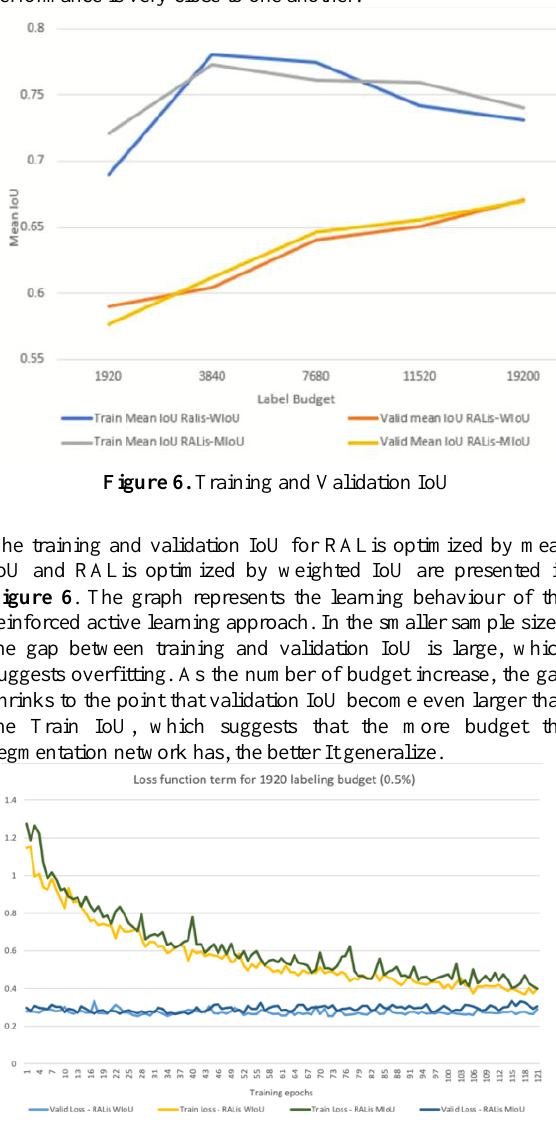
Figure 7. Training and Validation loss with 0.5% labeling budge